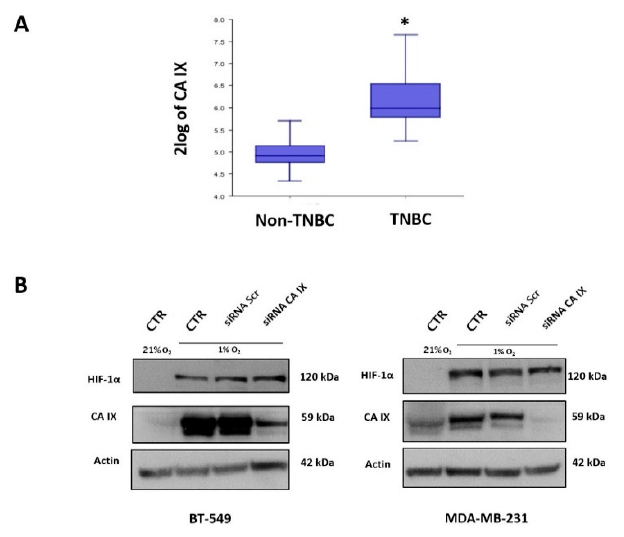
Figure 1. Analysis of carbonic anhydrase IX (CA IX) expression in triple-negative breast cancer (TNBC) sample patients and cell lines. ( A ) In silico analysis of mRNA CA IX expression was performed on two different datasets: GSE16391 which includes 55 non-triple-negative breast primary tumors and GSE76124 which includes 198 TNBC tumors from MD Anderson Cancer Center. The box plot represents a comparison of the CA IX expression between non-TNBC and TNBC tumor samples * p < 0.0001. ( B ) MDA-MB-231 and BT-549 cells were transfected for 48 h with CA IX-specific siRNAs (100 nM) or non-targeting siRNAs (siRNA Scr) (100 nM), used as negative control, in 1% O 2 . A control was performed in 21% O 2 . CA IX protein levels were analyzed using Western blot analysis. Actin was used as loading control. Representative data from one of three experiments are shown.